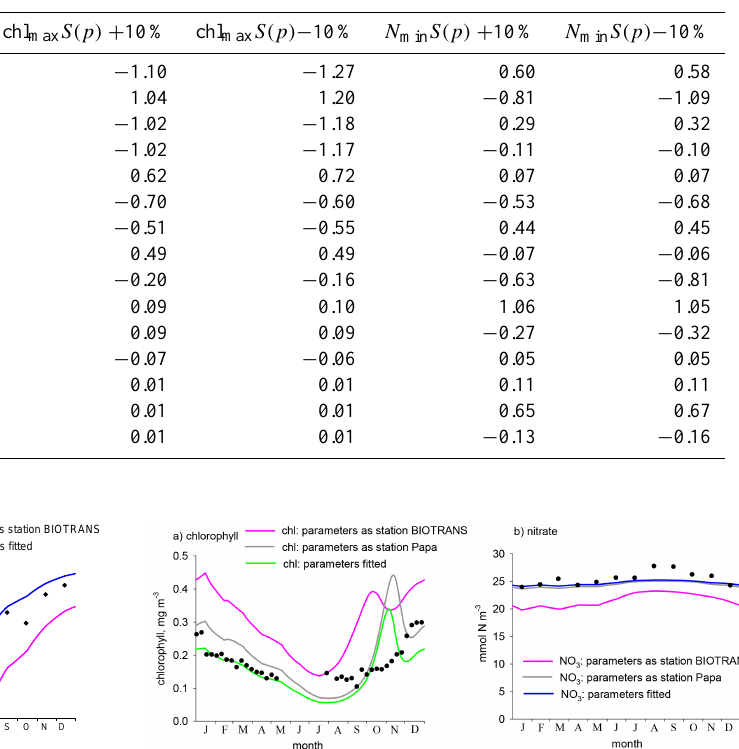
Table 4. Model sensitivity analysis: station BIOTRANS. Variables are chl av (average chlorophyll day 150–300), chl max (peak bloom chloro- phyll) and N min (minimum nitrate during seasonal drawdown). Parameters ranked according to sensitivity to chl max .